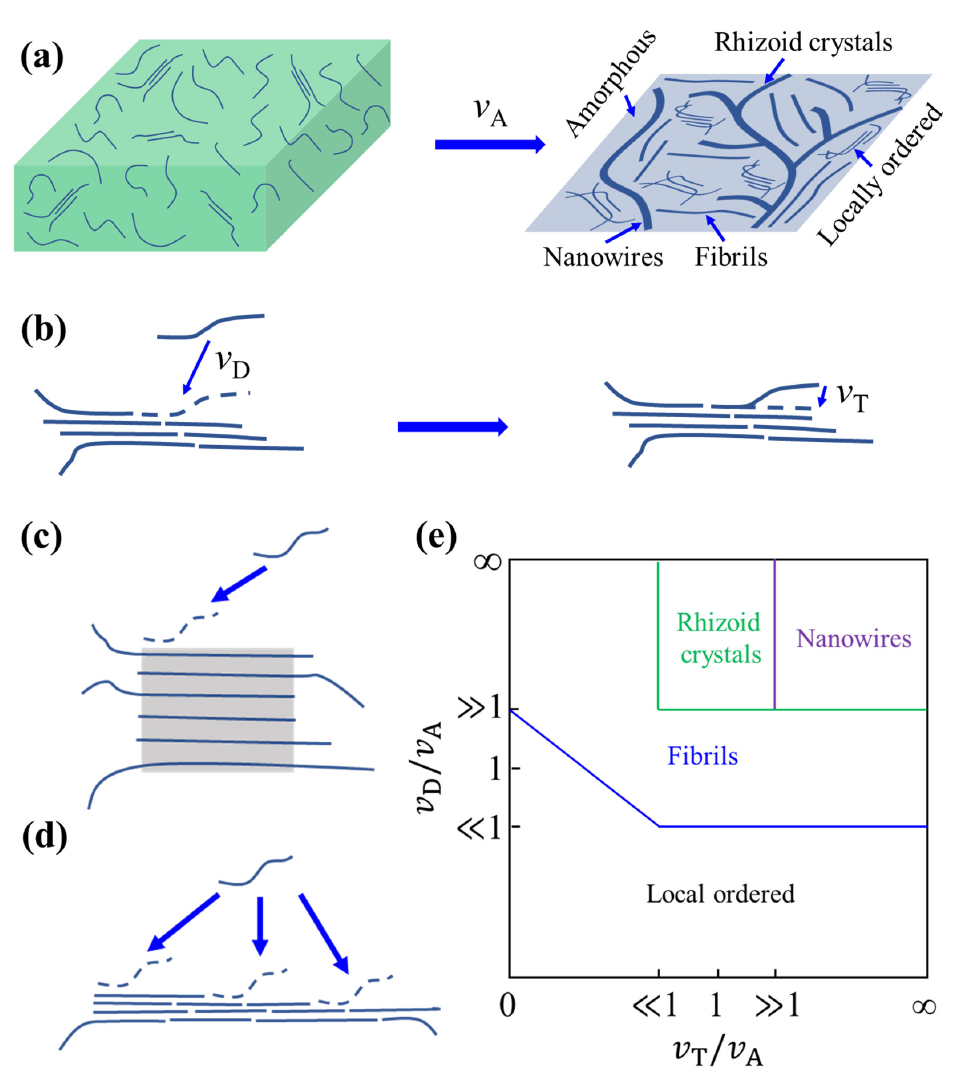
Figure 7. ( a – d ) The schematic diagrams of the crystallization process of D-A conjugated polymer crystals based on the D-CT theory. ( a ) The aggregate process of polymer chains. ( b ) The diffusion and conformational transition processes of polymer chains. ( c , d ) The possible growth directions of a single polymer chain. ( e ) The diagram of how v D , v A and v T values affect the morphology of D-A conjugated polymer crystals. These were adapted from reference [117] with permission from Copyright 2022 Elsevier Ltd.